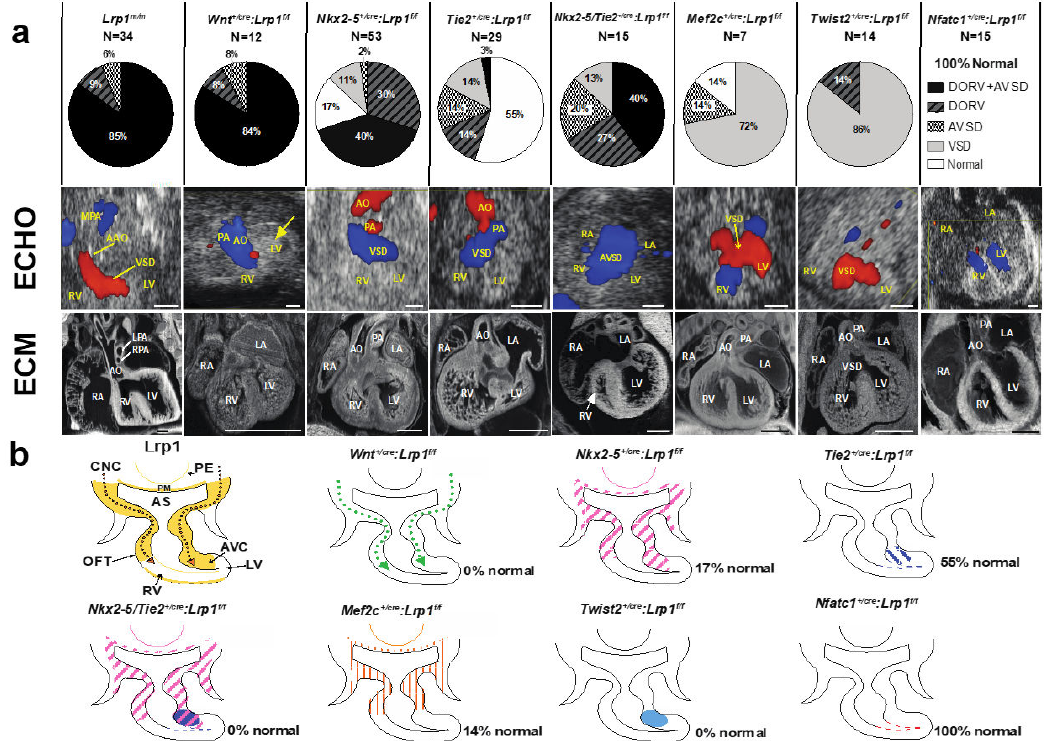
Figure 1. Conditional Cre deletion of the floxed Lrp1 allele. Conditional Lrp1 knockout in different cell lineages during cardiac development was carried out using different Cre drivers. ( a ) Pie charts illustrating the percentages of different cardiac phenotypes and Lrp1 m/m cardiac phenotypes. ( b ) Lrp1 expression is illustrated in yellow in developing heart around E10.5–E11.5. Targeting Lrp1 deletion in neural crest cells using Wnt1-Cre ( Wnt1 +/Cre : Lrp1 f/f ) recapitulates the cardiac phenotypes of Lrp1 m/m mutants, which is illustrated in dotted green arrows. The ablation of LRP1 expression using Nkx2-5-Cre (Nkx2-5 +/Cre : Lrp1 f/f ) is illustrated in pink hash, specifically in the PM, PE, AHF, and AV canal cushion. The ablation of LRP1 expression using Tie2-Cre ( Tie2 +/Cre : Lrp1 f/f ) is illustrated in blue hash and blue dots. The ablation of Lrp1 in double knockout of Nkx2-5-Cre and Tie2-Cre (Nkx2-5 +/Cre Tie2 +/Cre : Lrp1 f/f ) is illustrated in pink and purple hash. The combined deletion of Lrp1 mediated by Tie2-Cre and Nkx2-5-Cre together demonstrated the high penetrance of the DORV/AVSD phenotype and increased the penetrance of AVSD. The ablation of Lrp1 using Mef2c-AHF-Cre ( Mef2c-AHF +/cre : Lrp1 f/f ) is illustrated in orange hash. The ablation of Lrp1 using Twist2-Cre ( Twist2 +/cre : Lrp1 f/f ) is illustrated in navy blue. There is no cardiac phenotype of Nfatc +/cre : Lrp1 f/f ; the ablation of LRP1 expression is expressed in red. AHF: anterior heart field; AO: aorta; AS: aortic sac; AVC: atrioventricular canal; AVSD: atrioventricular septal defect; CNCC: cardiac neural crest cells; DORV: double outlet right ventricle; LA: left atrium; LV: left ventricle, OFT: outflow tract; PA: pulmonary artery; PE: pharyngeal endoderm; PM: pharyngeal mesoderm; RA: right atrium; RV: right ventricle; VSD: ventricular septum defect. Scale bars: 0.5 mm (modified from reference [27] Figure 3, with additional data